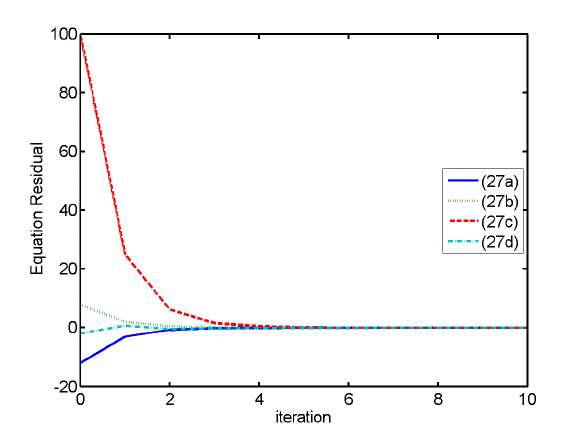
Figure 3. A plot of residuals when solving Equation (27) using Newton’s Method when x = 0.